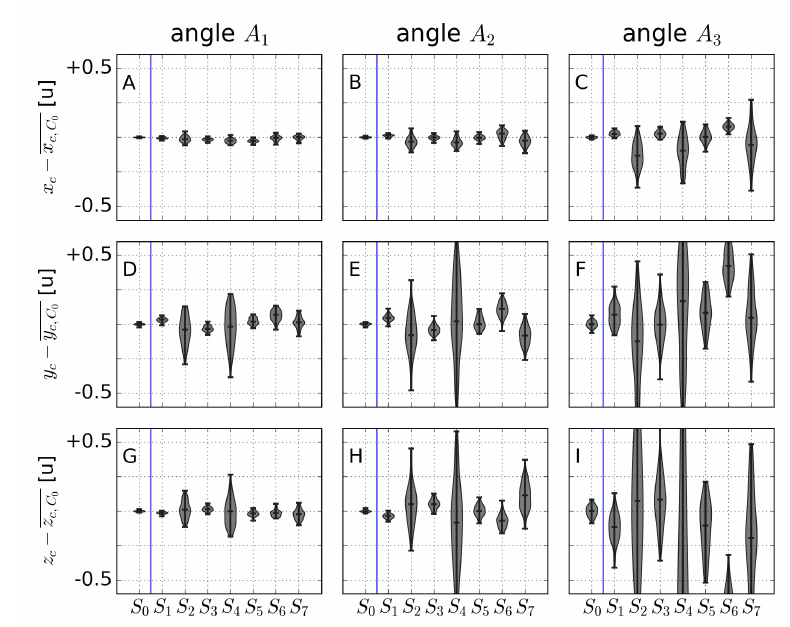
Figure 12. Demeaned camera position co-ordinates x c , y c , and z c for angles A 1 ( A , D , G ), A 2 ( B , E , H ), and A 3 ( C , F , I ) for model M 2 . The unit length “u” corresponds to the side of the squares of the grid.